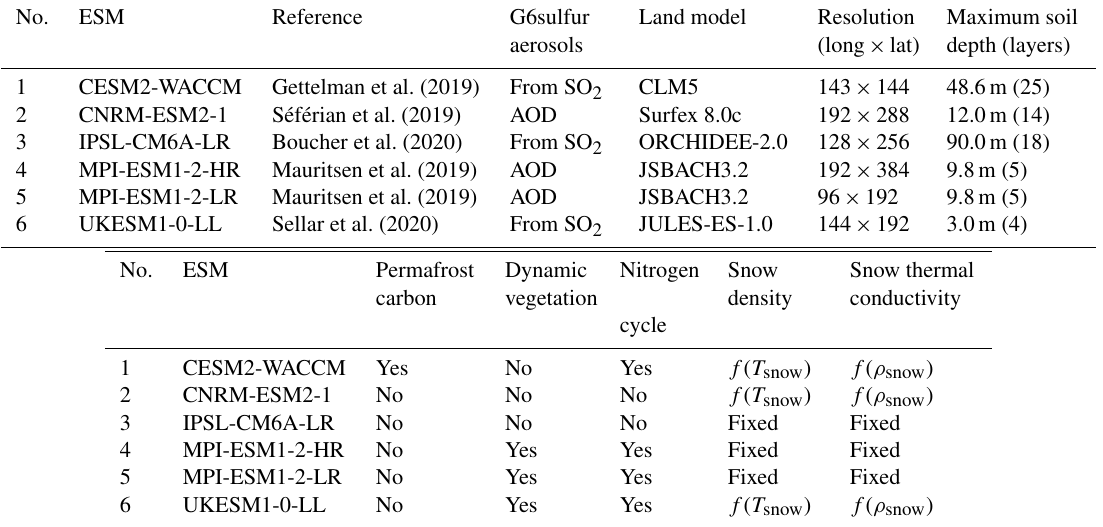
Table 1. The CMIP6 models used in this study and their main features. The attributes of ESMs listed here are relevant to the soil temperature (TSL), net primary productivity (NPP), and gross primary productivity (GPP) outputs, which are used to drive a mechanistic soil carbon model for simulating permafrost carbon dynamics. G6sulfur aerosols indicate the use of prescribed aerosol optical depth (AOD) or internally calculated values derived from injected SO 2 (Visioni et al.,